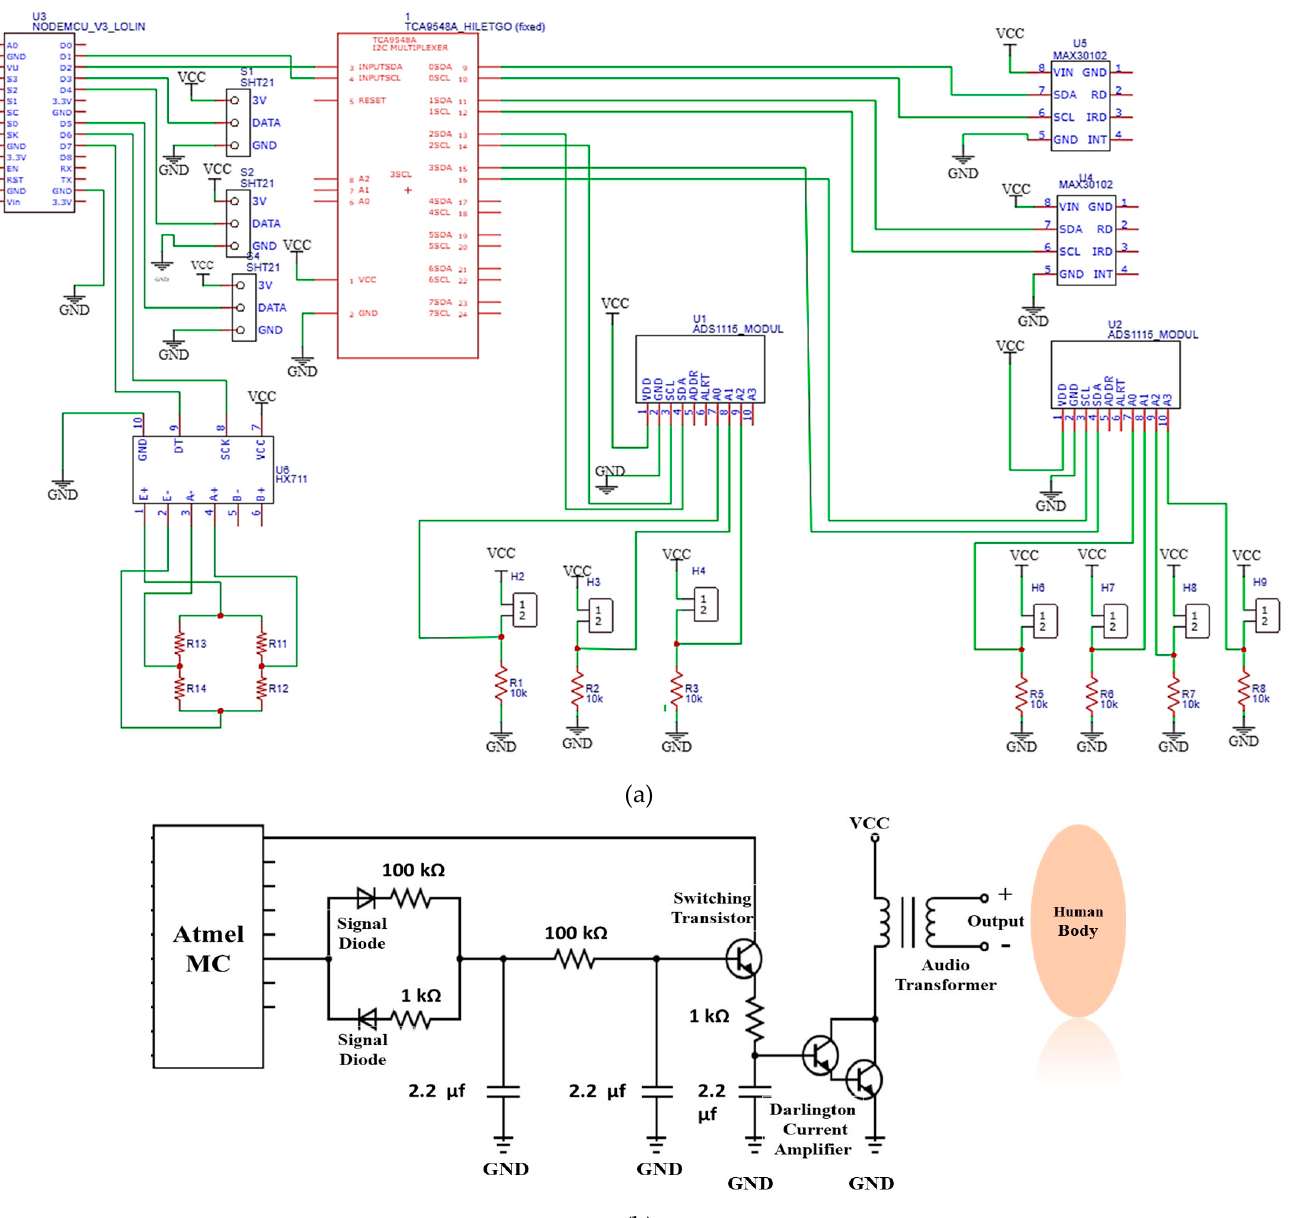
Figure 4. ( a ) Schematic of all sensors used and their interface with the main microcontroller. ( b ) Schematic of the ES unit and its interface with the human body.